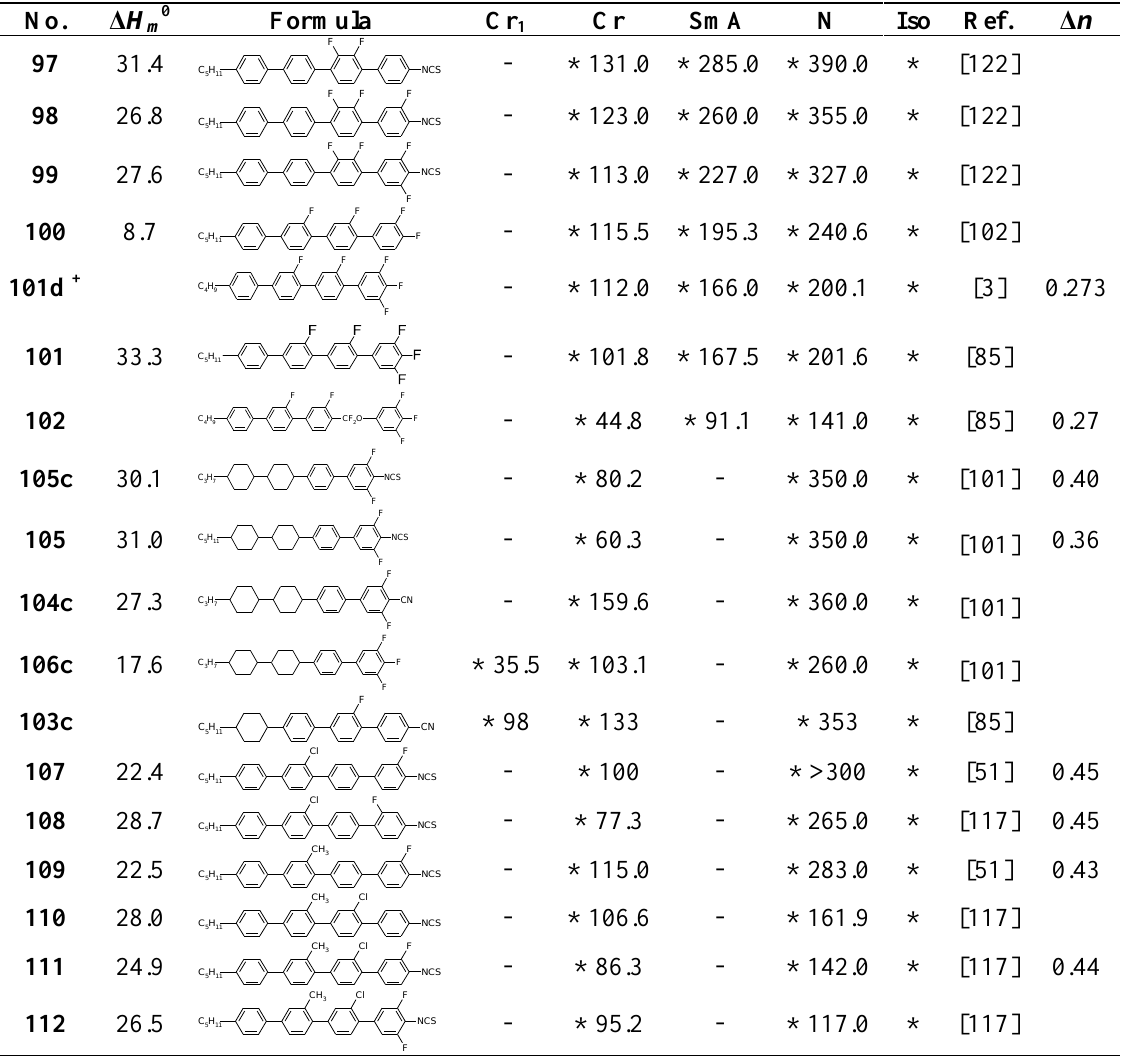
Table 14. Phase transition temperatures [°C], melting enthalpies [kJ/mol] and birefringence of four-ring